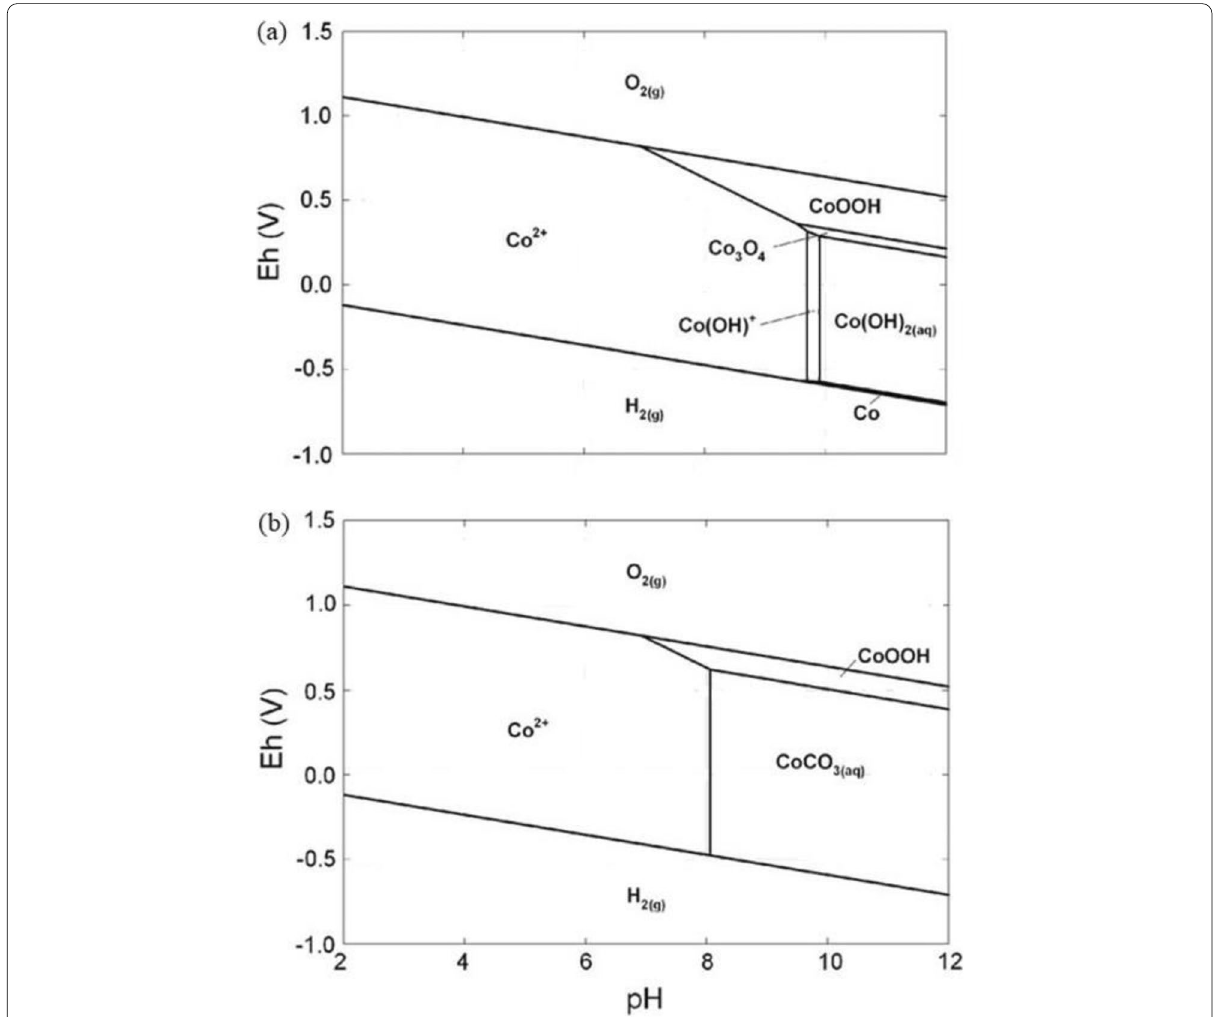
Fig. 3 Pourbaix diagram of cobalt in ( a ) closed and ( b ) open systems